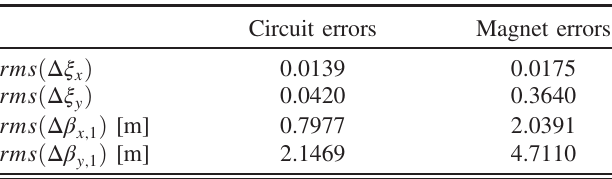
TABLE II. RMS of the chromaticity and chromatic function error of the 10 error seeds.